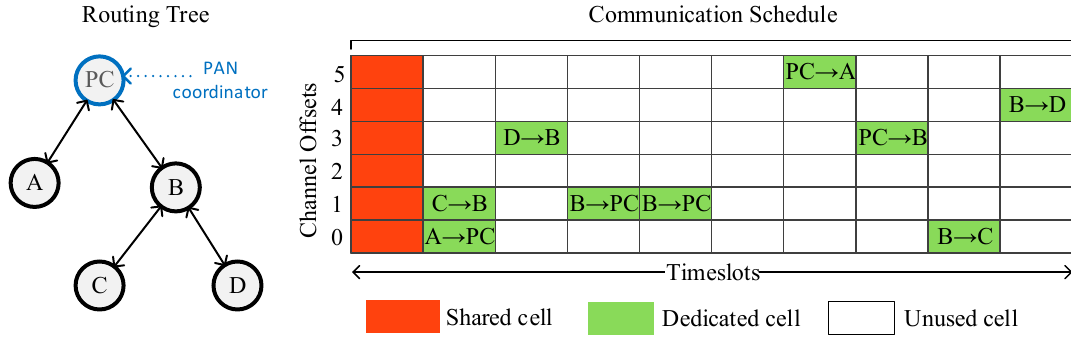
Figure 1. A five-node topology with a simple time slotted channel hopping (TSCH) schedule using dedicated cells for unicast transmissions and shared cells for broadcast